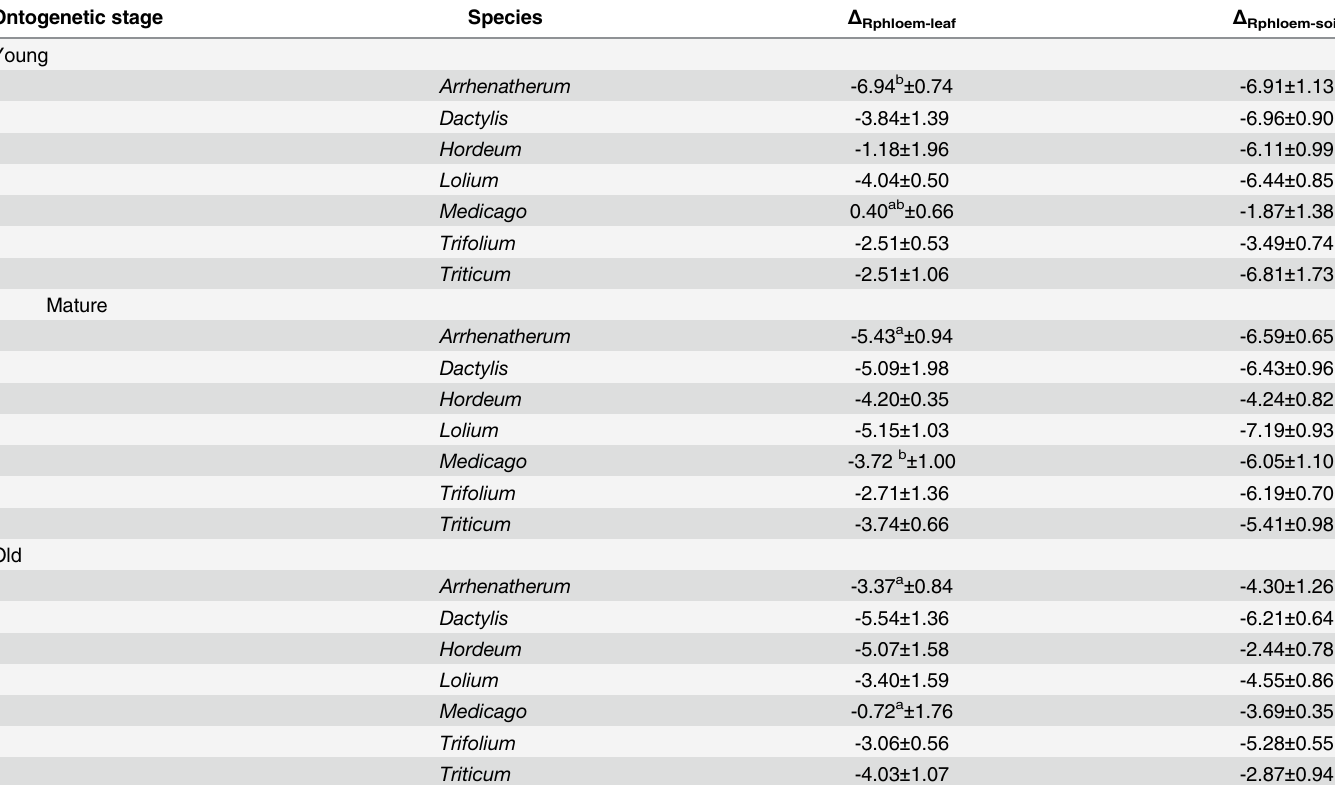
Table 4. Respiratory C isotope fractionation ( Δ R ) at three ontogenetic stages (young foliage, “ young ” ; maximum growth rate, “ mature ” ; beginning of senescence, “ old ” ) in seven species ( Arrhenatherum elatius ; Dactylis glomerata ; Hordeum vulgare ; Lolium perenne ; Medicago sativa ; Trifo- lium pratense ; Triticum aestivum ). Δ R is calculated between phloem sap organic matter and leaf-respired CO 2 ( Δ Rphloem-leaf ) as well as between phloem sap organic matter and soil-respired CO 2 ( Δ Rphloem-soil ). Within one column, different letters indicate significant difference between ontogenetic stages within a species (p (cid:5) 0.05). Note that only significant differences are